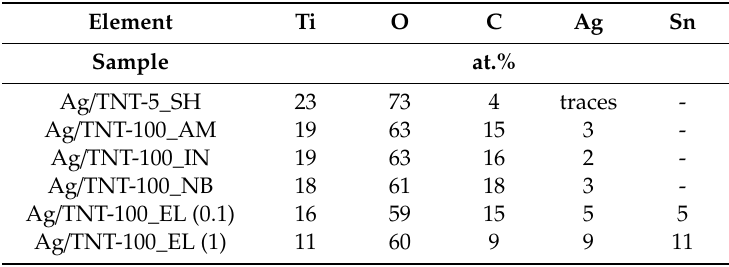
Table 3. The surface concentration of elements identified by XPS on the surface of selected samples.